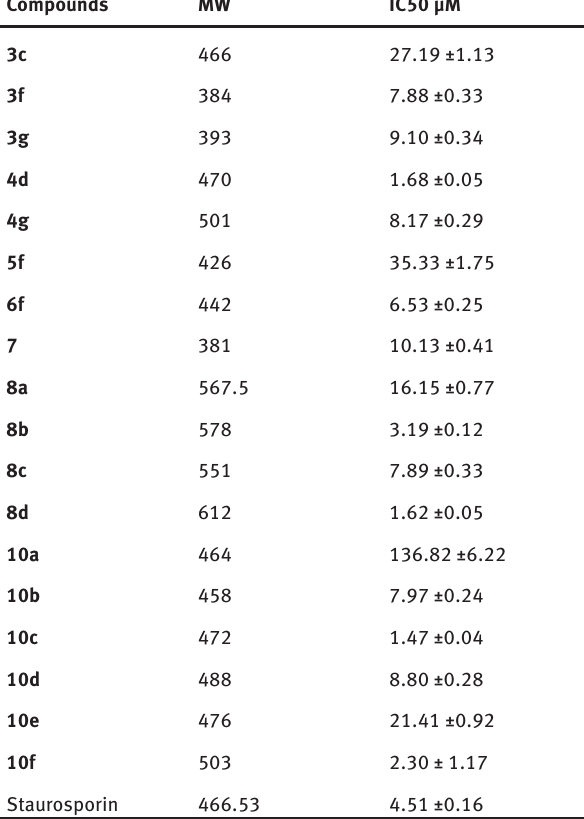
Table 1: The cytotoxic activity of several newly synthesized compounds against human breast cancer cell lines (MCF7).